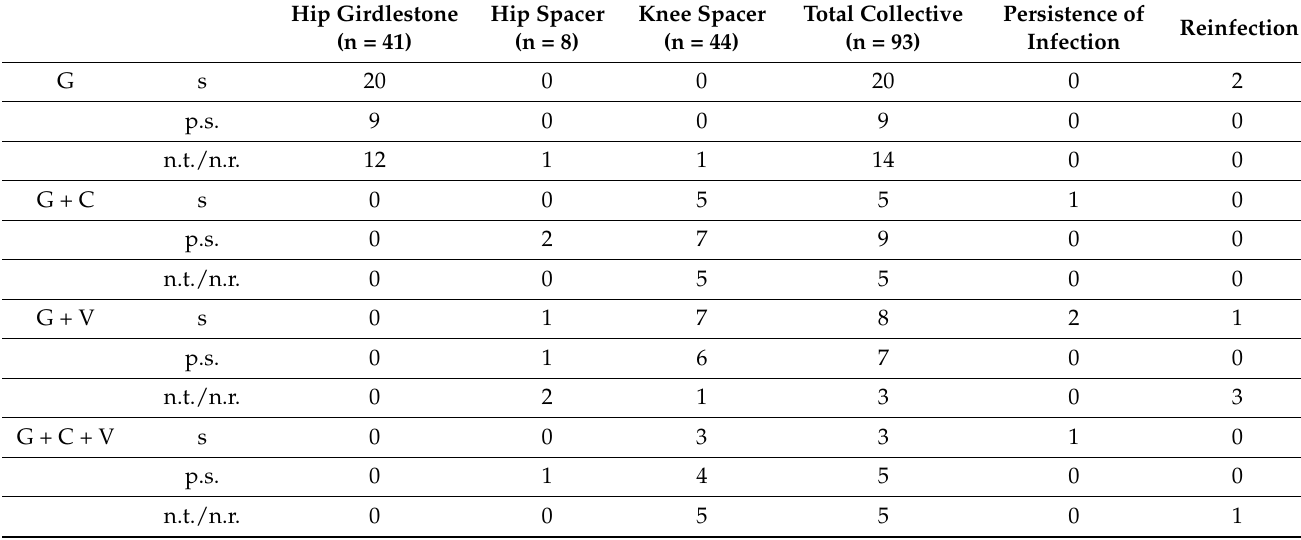
Table 3. Evaluation of each antibiotic impregnation with regard to the susceptibility of the particular pathogen organism(s) and the emergence of persistence of infection or